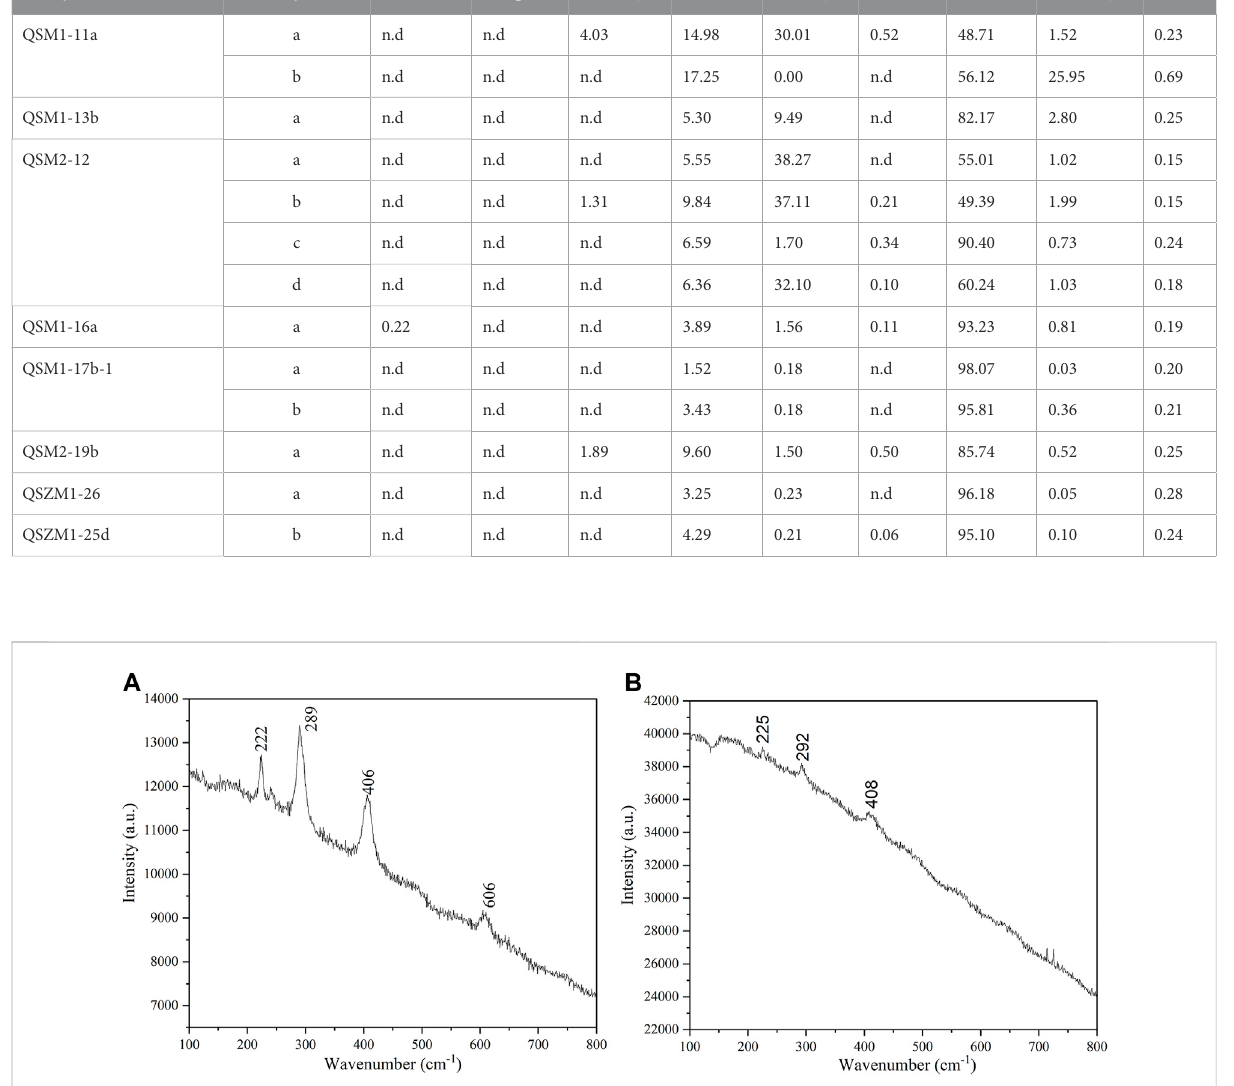
TABLE 1 The chemical composition of the shell beads from the Qulong Site (wt%). Sample number